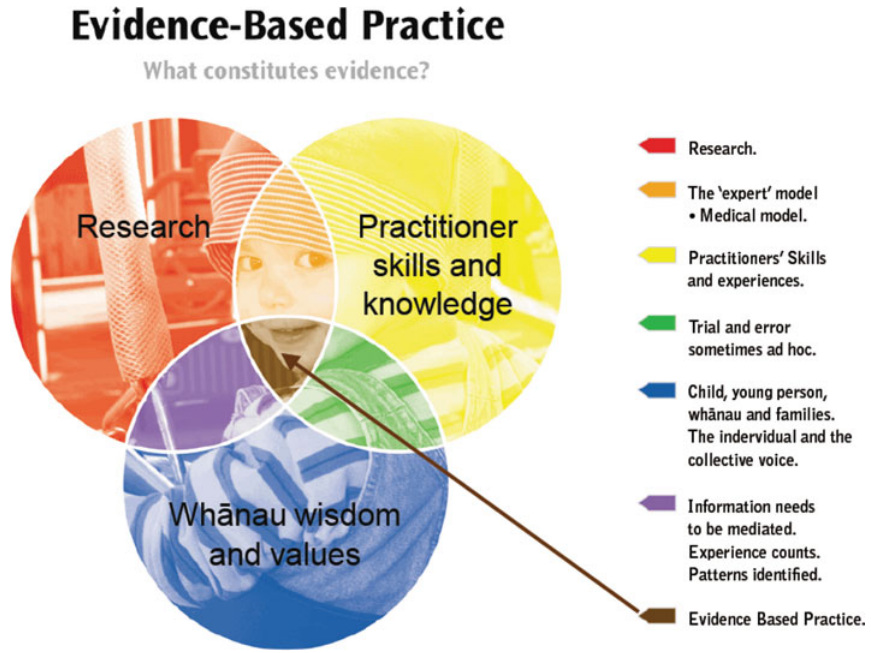
(Colour online) Evidence-Based Practice (EBP) Framework (Bourke, Holden, & Curzon,